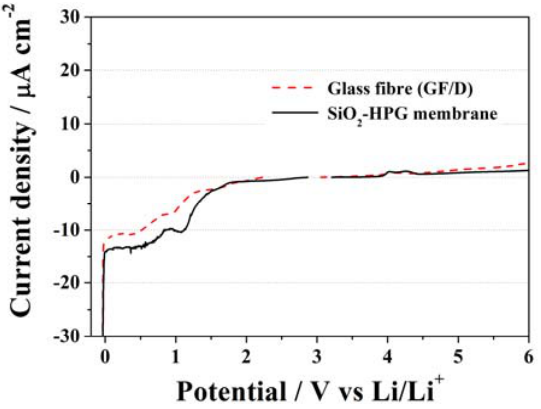
Figure 6. Linear sweep voltammograms of the SiO 2 –HPG membrane and glass fiber separator using 1 mol·L − 1 (LiPF 6 ) dissolved in EC:DMC (1:1) w / w as electrolyte. Scan rate 0.1 mV·s − 1